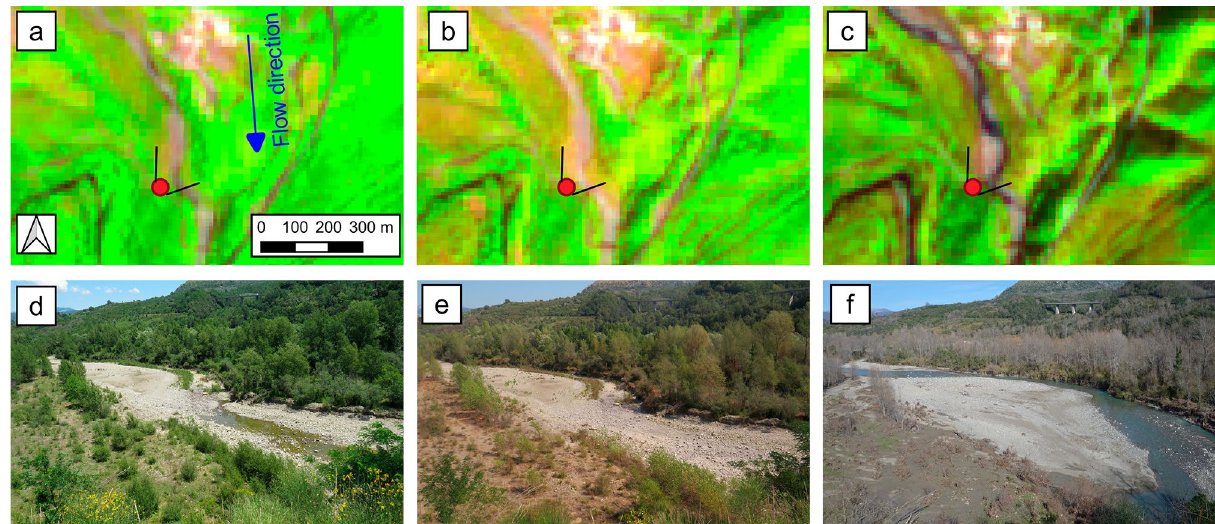
Figure 5. Test cases 2, 4, 5, S1 reach, ( a ) FCI of 26 June 2020, ( b ) FCI of 19 September 2020, ( c ) FCI of 6 February 2021, (red point) photo shooting location, ( d ) photo taken on 26 June 2020, ( e ) photo taken on